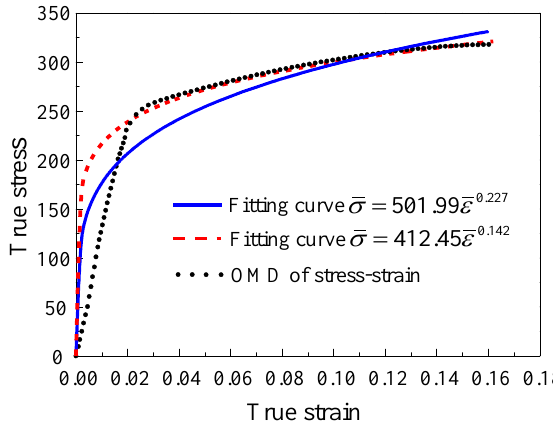
Figure 11. OMD of stress – strain and power function fitting curves.